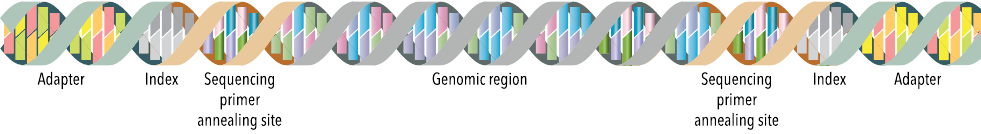
Figure 2. Primer and fragment design for library preparation. The P. falciparum gene fragments of interest are amplified with gene-specific primers, in a “gene-specific PCR” (1). The primers anneal to loci in the P. falciparum genome, while encoding non-annealing overhangs, which are then incorporated into the PCR products during amplification. The non-annealing overhangs are identical on all gene-specific primers, and serve as annealing site for the index primers (2), which can in turn anneal to all amplified gene fragments. The index primers also encode individual 8-base indices as well as an adaptor sequence. The index and adapter sequence are incorporated into the PCR product (denoted amplicon from here on), which can then bind to the Miseq flow cell through the adaptor sequence, and be identified through sequencing of it’s unique index